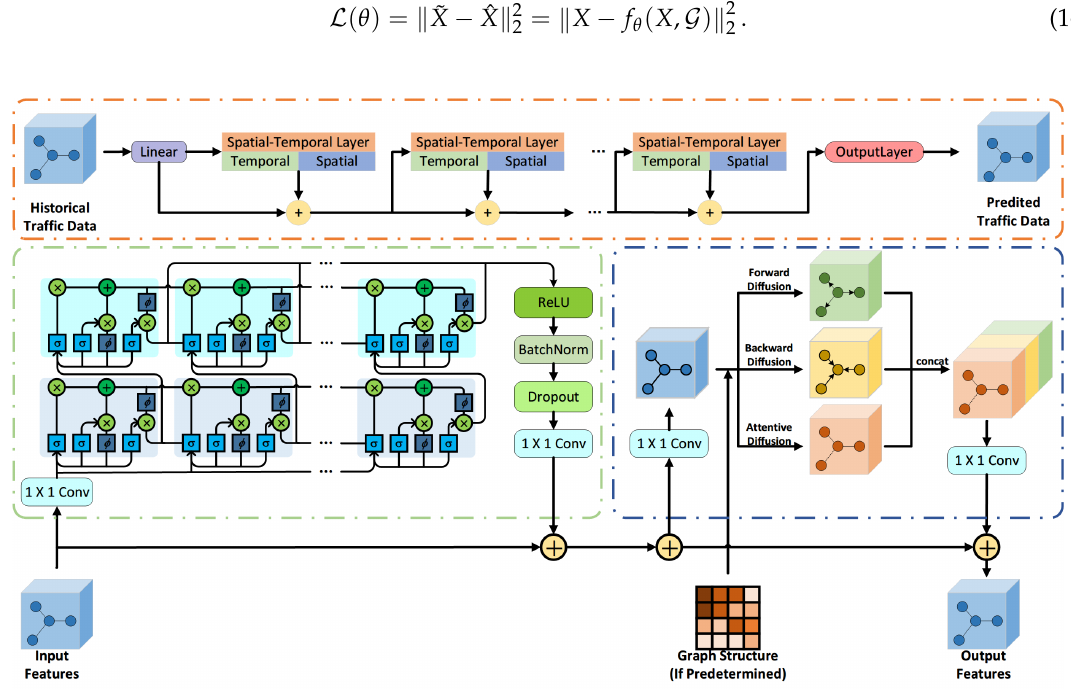
Figure 4. The schematic illustrations of our deep learning framework (top): (1) we rescale input traffic graph signals with a linear activation function; (2) we extract seasonality and trend features from node signals using a Long Short-Term Memory (LSTM)-based block and resize them into graph signals; (3) we use MDC block to capture spatial dependencies of previous graph signals; (4) we combine the two blocks and stack them with residual connection, which enables the model to train deeper and learn multi-scale temporal-spatial features; (5) finally, an output layer equipped with an attention mechanism is used to generate the forecasting